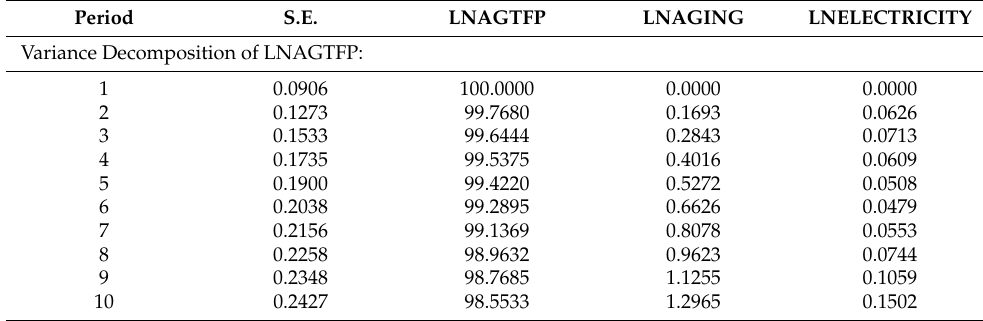
Table A1. Impulse response and variance decomposition